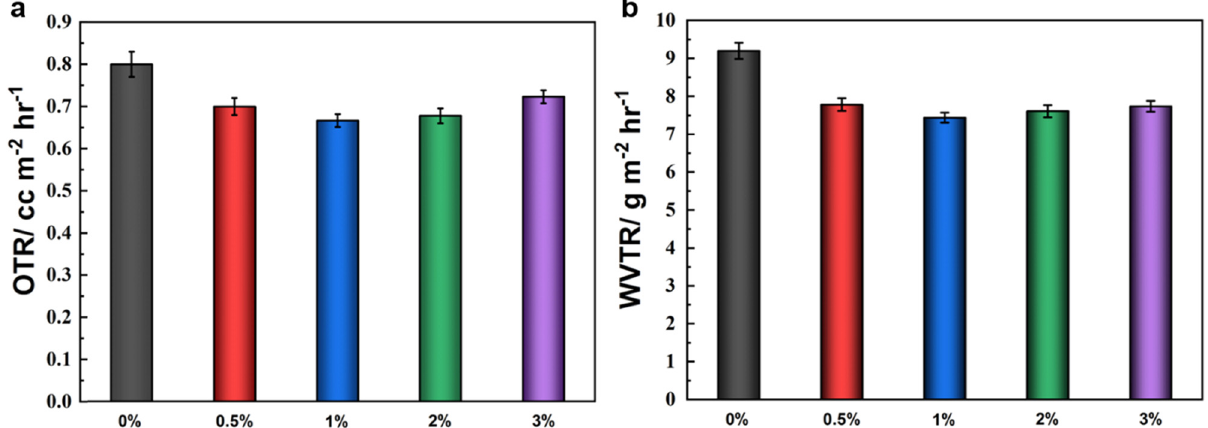
Figure 4: OTR ( a ) and WVTR ( b ) of di ff erent composite